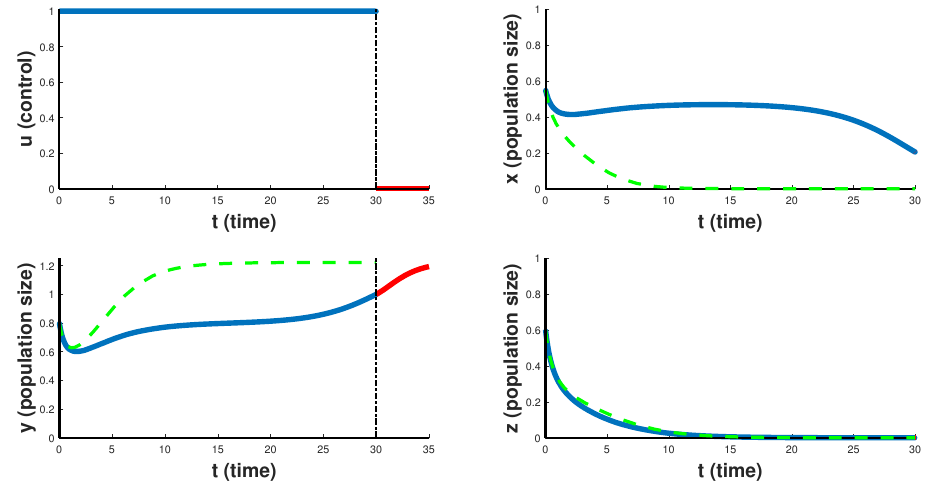
Figure 3. The optimal solutions x ∗ ( t ) , y ∗ ( t ) , z ∗ ( t ) and optimal control u ∗ ( t ) for the values of the parameters r = 0.6, p = 1.1, q = 1.0, η = 0.9, γ = 1.1, α 1 = 1.0, α 2 = 0.8, α 3 = 0.9, β 1 = 0.9, β 2 = 0.9,